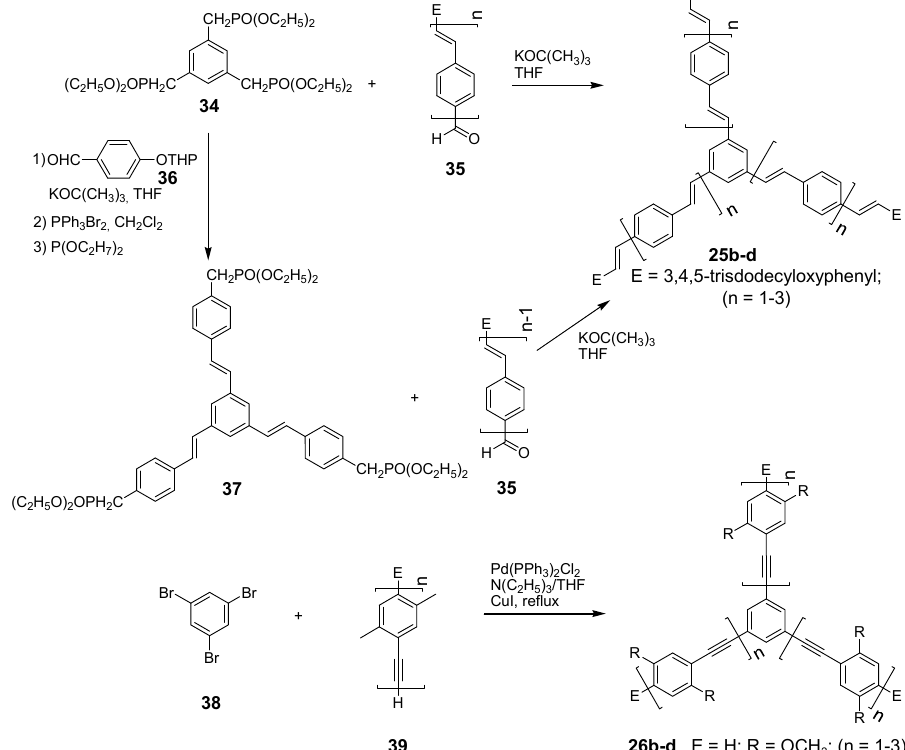
Scheme 9. Synthesis of stars 25 with OPV and 26 with oligo(phenylene ethynylene) (OPE)